Question: Does the figure show an increasing or a decreasing trend?
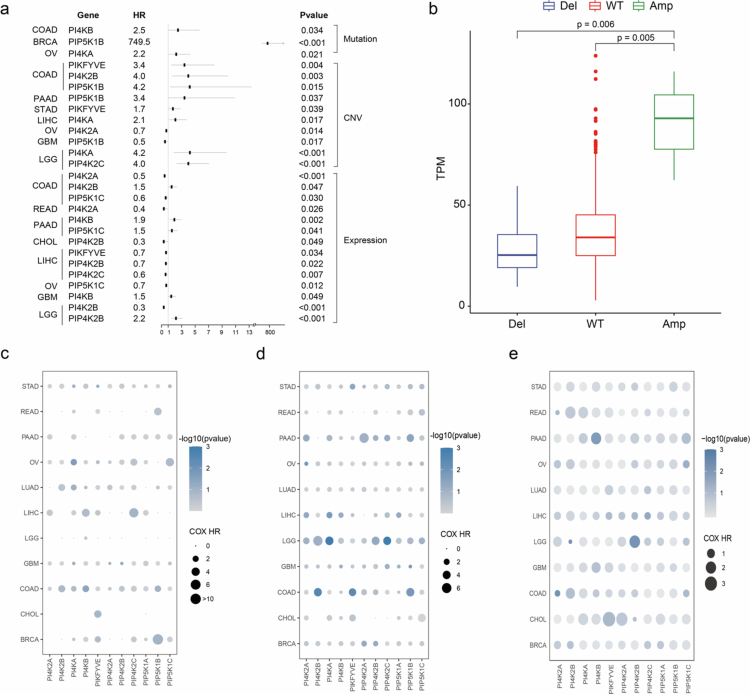
Answer: increasing